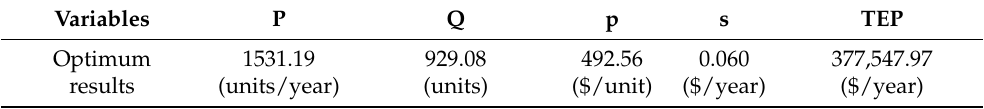
Table 4. Optimum results from Example 3.